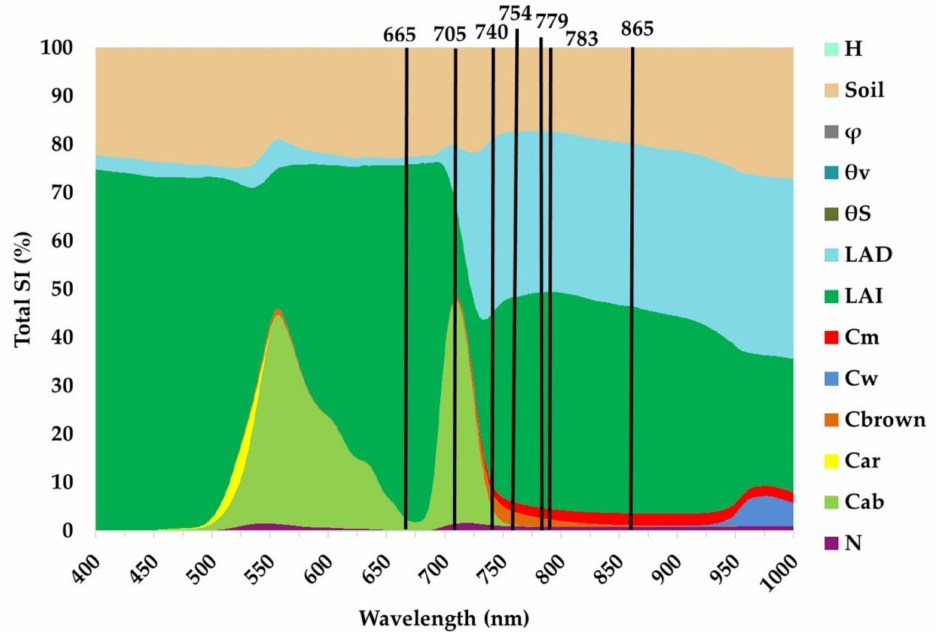
Figure 9. Global Sensitivity Analysis of the PROSAIL input parameters. The dimension of the sensitivity refers to the relative contribution (SI) of each input variable and the vertical bars represent the positions of the bands (solid lines, S-2; dotted lines, S-3) used to calculate the investigated SVIs. Input parameter ranges, full names of the variables and units are presented in Table